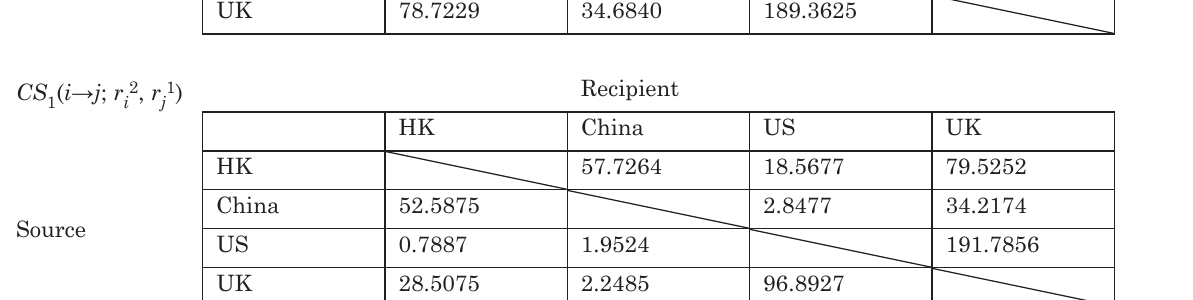
table of CS flecting” the table CS diagonal line.